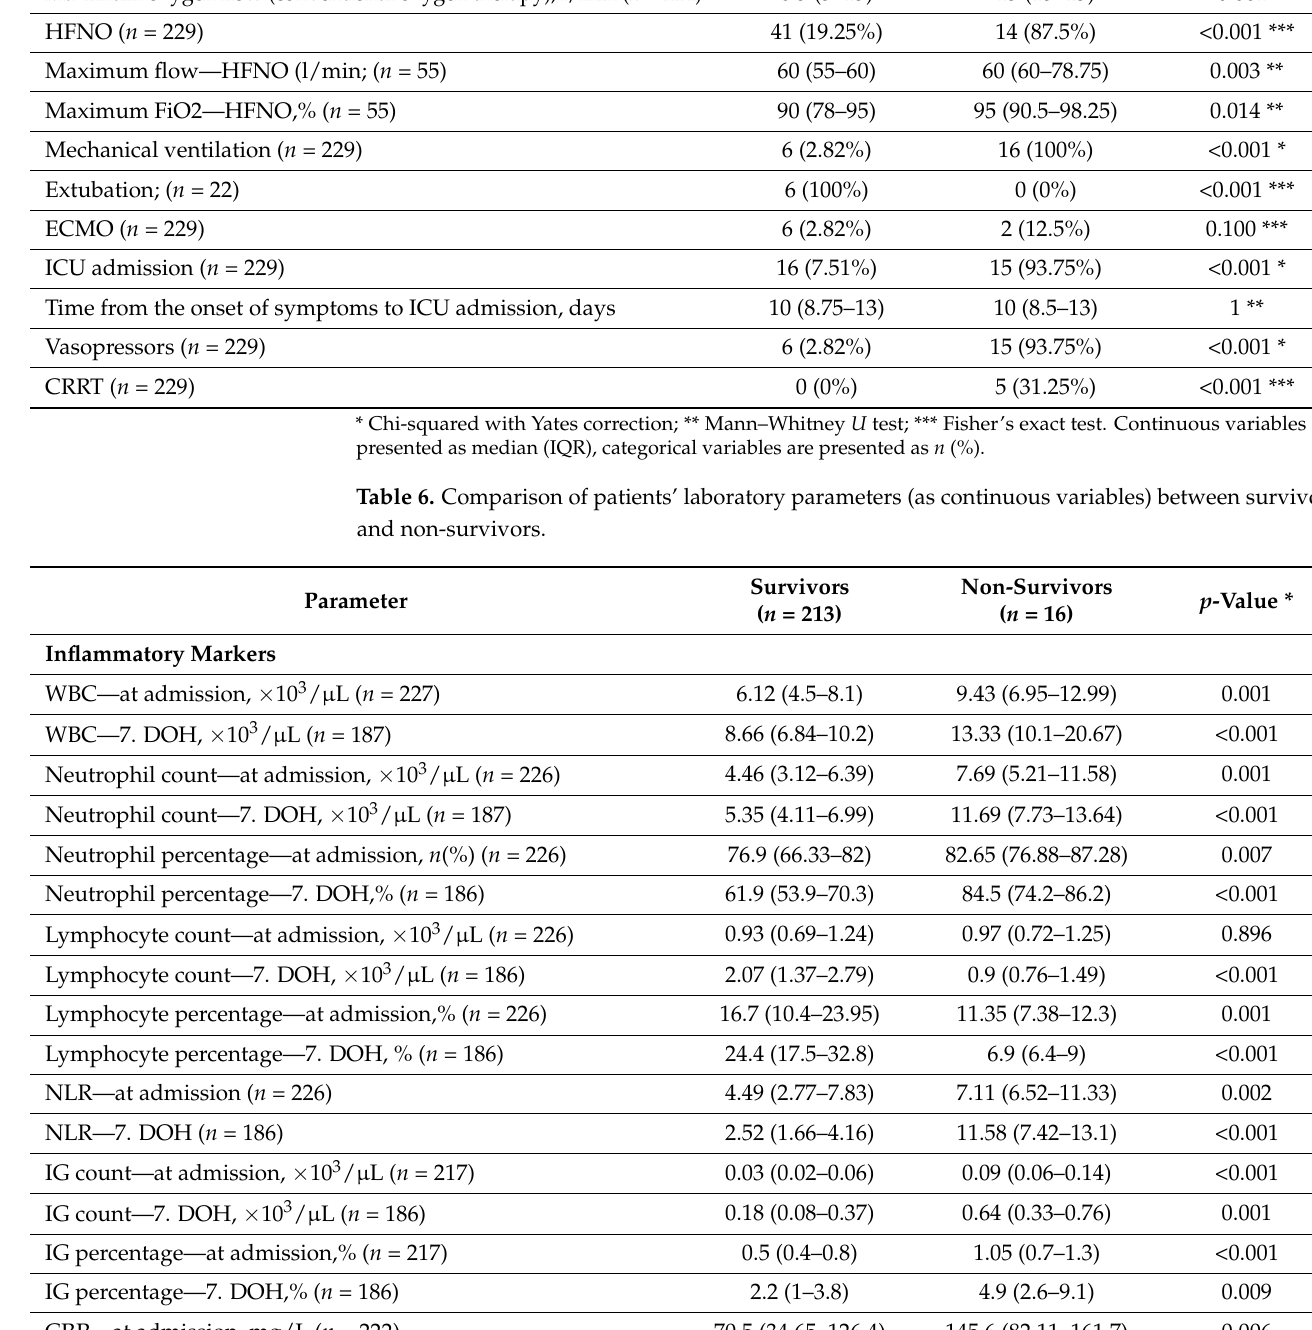
Table 5. Comparison of clinical patients’ characteristics between survivors and non-survivors.